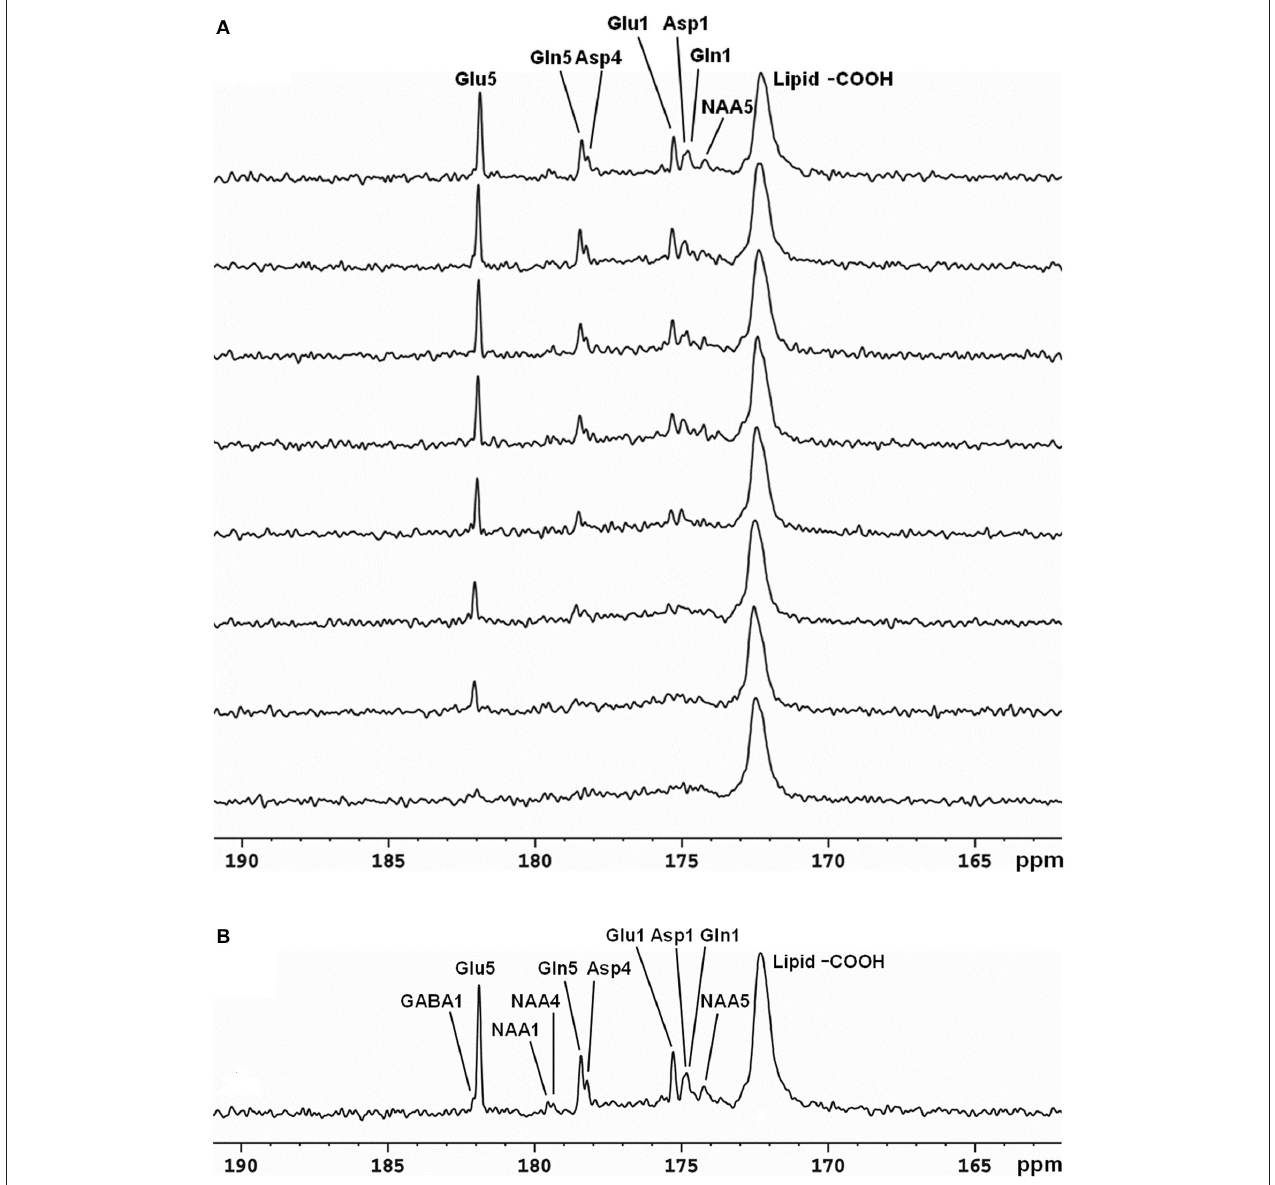
FIGURE 3 | Time-course spectra of Glu, Gln, and Asp turnover detected in the occipital lobe of human brain at 3 Tesla during intravenous infusion of [2- 13 C] glucose (A) and summed spectrum from the last 17 min of data acquisition (B) . In the summed spectrum, GABA C1, NAA C4, and NAA C1 were additionally detected. Acquisition parameters were: spectral width (SW) 5 kHz, number of data points 1,024, number of scan (NS) 128, TR 4s. Adapted from Li et al. [29].